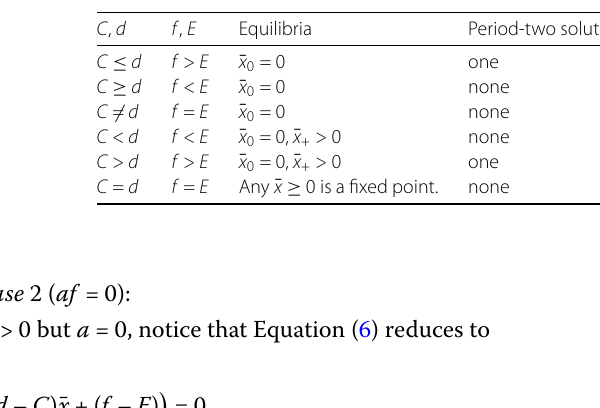
Table 3 Existence of equilibria and period-two solutions for a = 0, f >